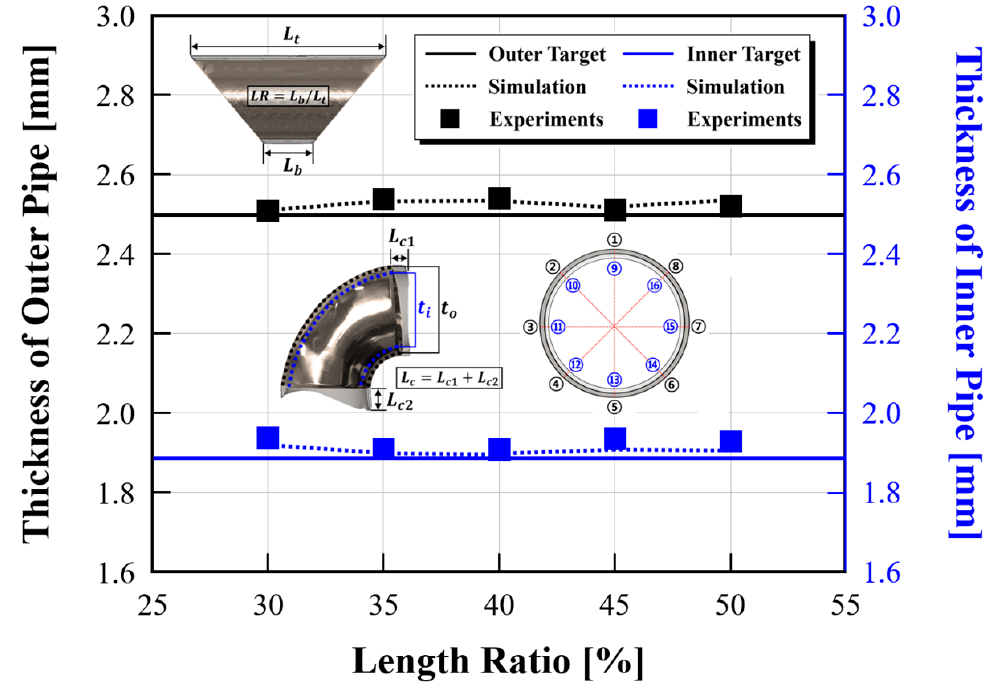
Figure 6. Results of dimensional precision measurement according to length ratio. Table 4. Dimensional measured values of forged bi-metal billet.